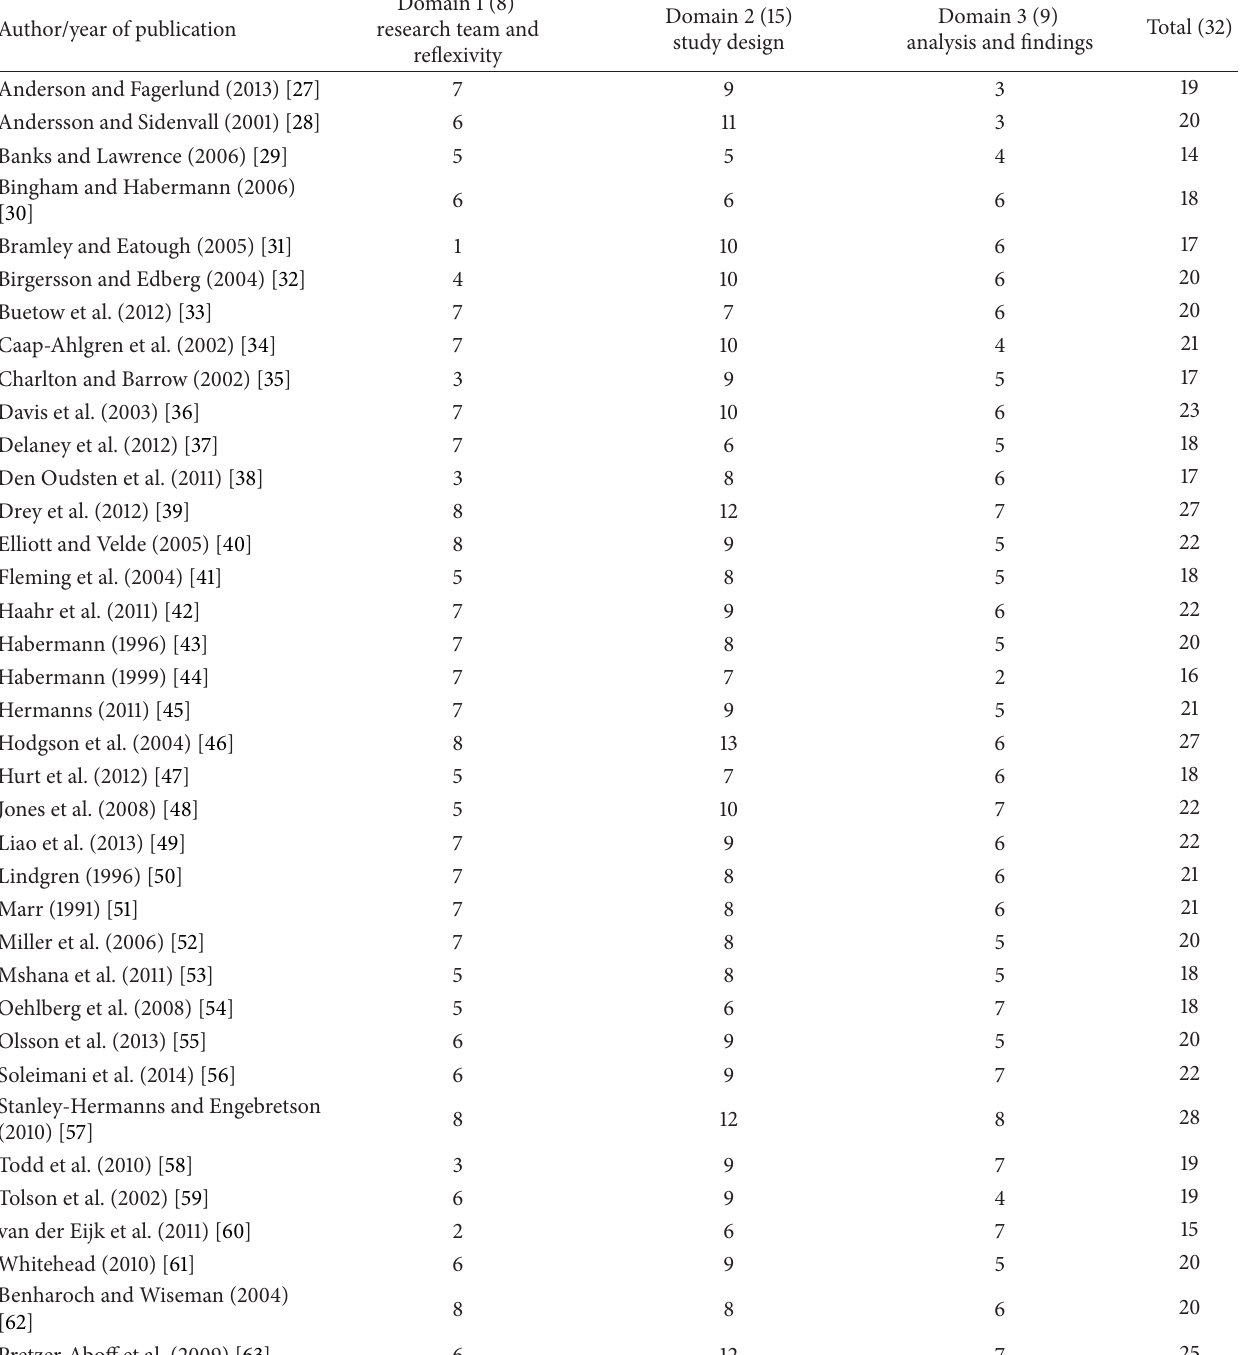
Table 2: The summary of results of the COREQ (Tong et al., 2007 [22]) appraisal for the 37 included